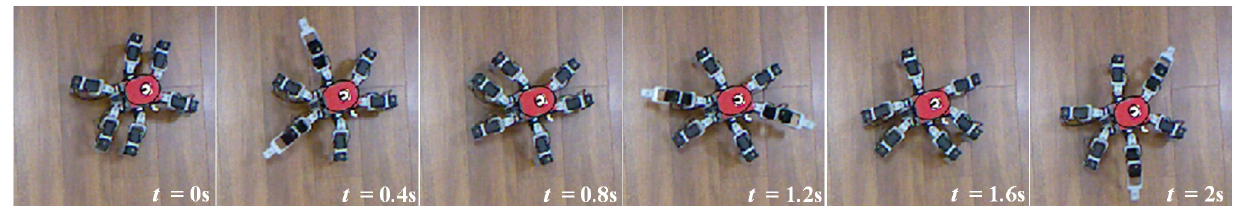
Figure 14. The experimental screenshots of the wave gait.